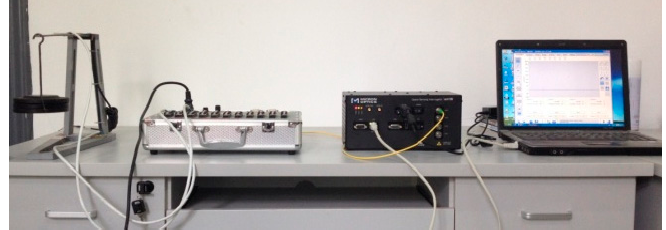
Figure 5. Layout of the calibration test.